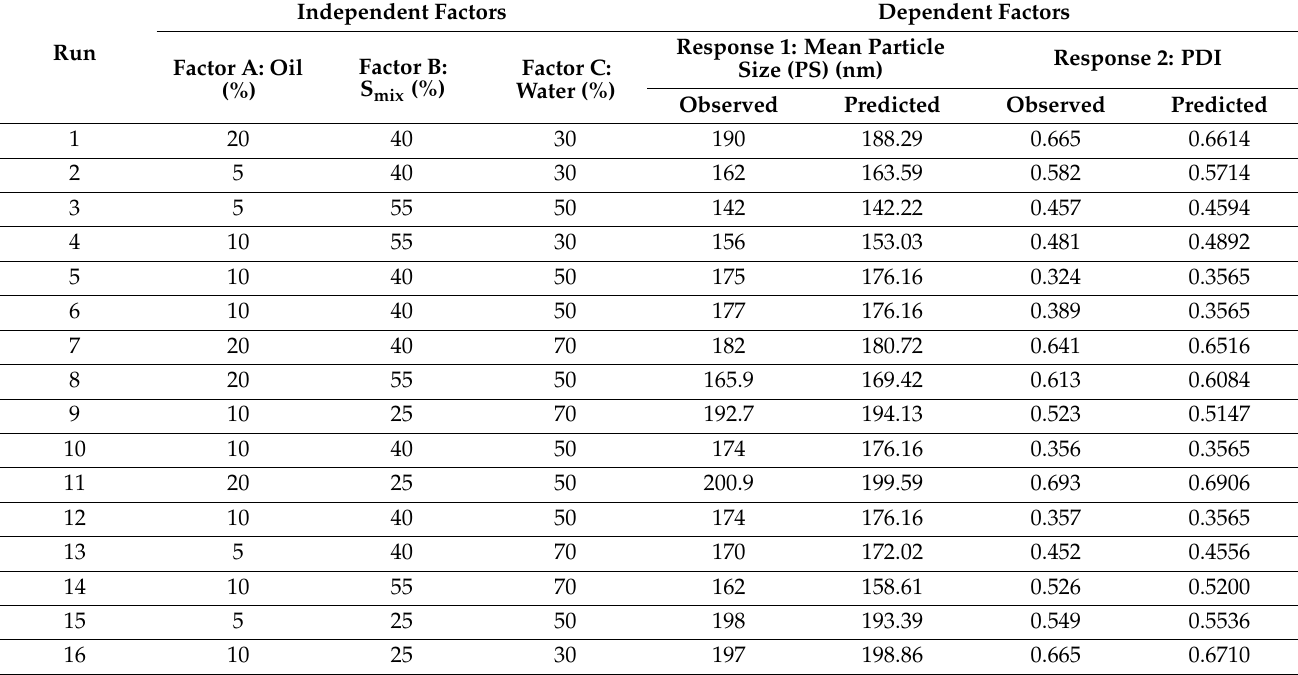
Table 3. The responses obtained (observed and predicted values) for various NE formulation trials.